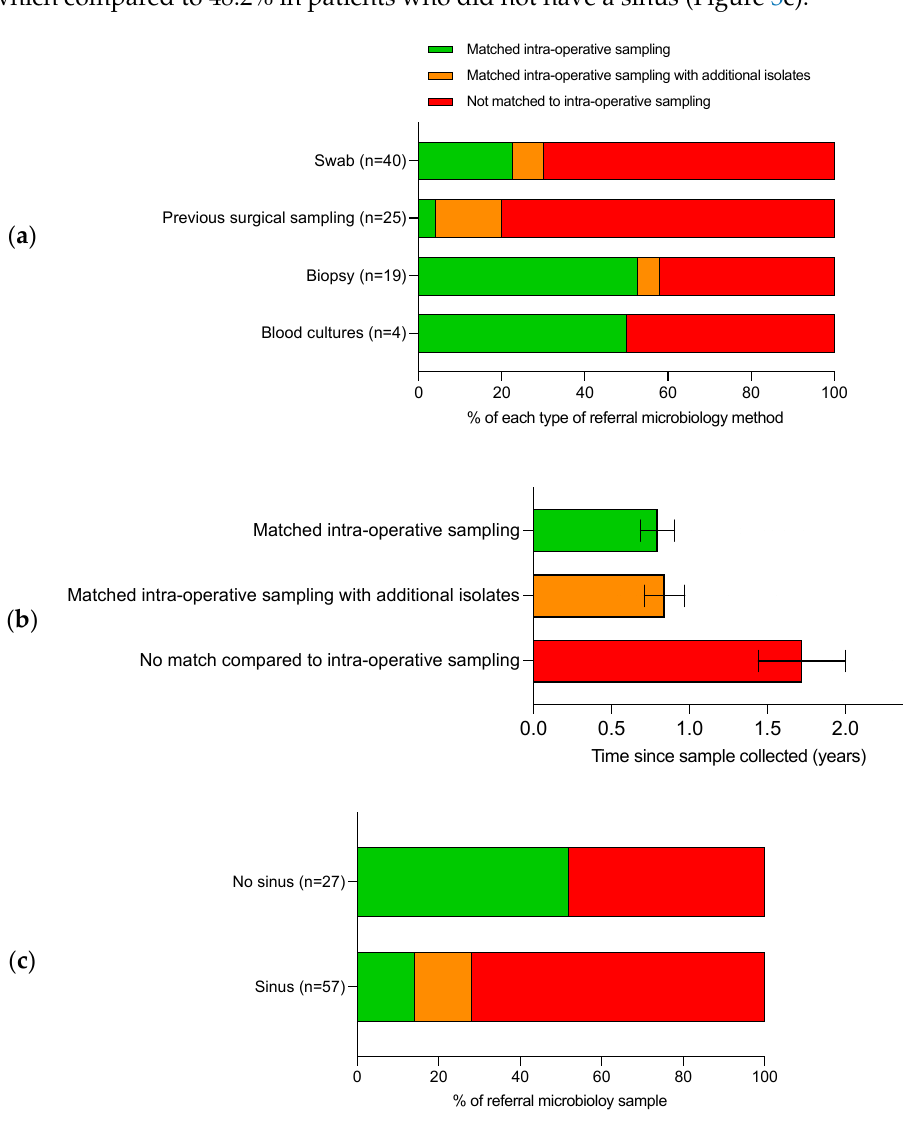
Figure 4. Multivariate logistic regression demonstrating that the presence of an active sinus, isolates from previous surgical sampling and increased time interval between referral sample and intra-